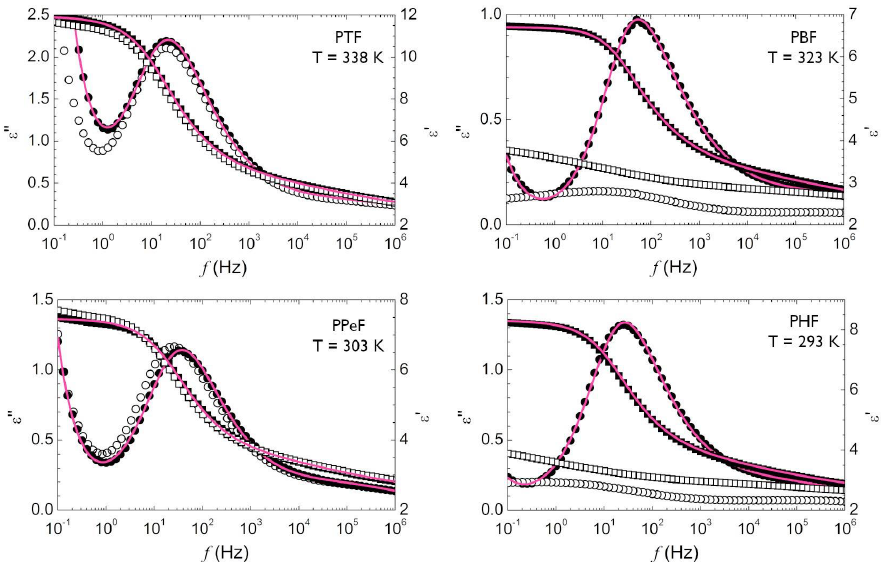
Figure 3. BDS results showing the segmental relaxation of the polymers. Circles correspond to ε’’ and squares correspond to ε’. Solid symbols show the results for FC samples , while empty ones show the results for SL samples. Continuous lines correspond to fittings, as detailed in the main text. The data corresponding for FC PBF was adapted from Ref [28].